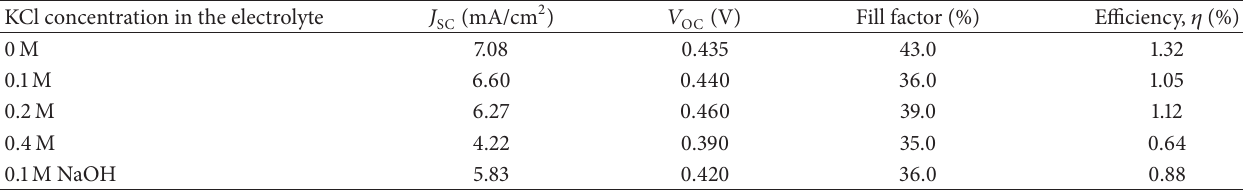
Table 4: Performance parameters of CdSe QDSSCs with electrolytes having various amounts of KCl additive. Electrolyte used: 0.5 M Na 0.1M S in ethanol/water (8:2 by volume).